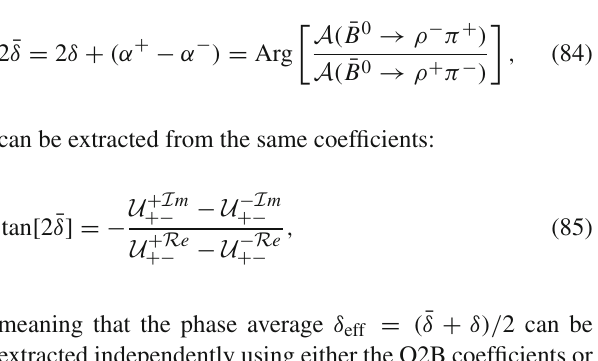
the interference-related coefficients for B 0 → ρ ± π ∓ :